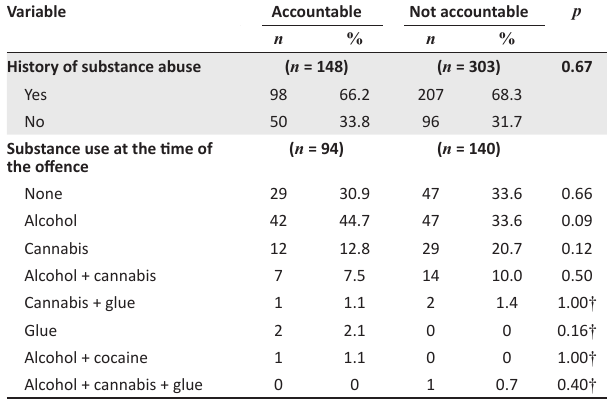
TABLE 3: History of substance abuse and the substance use of the observati at the time of the offence.